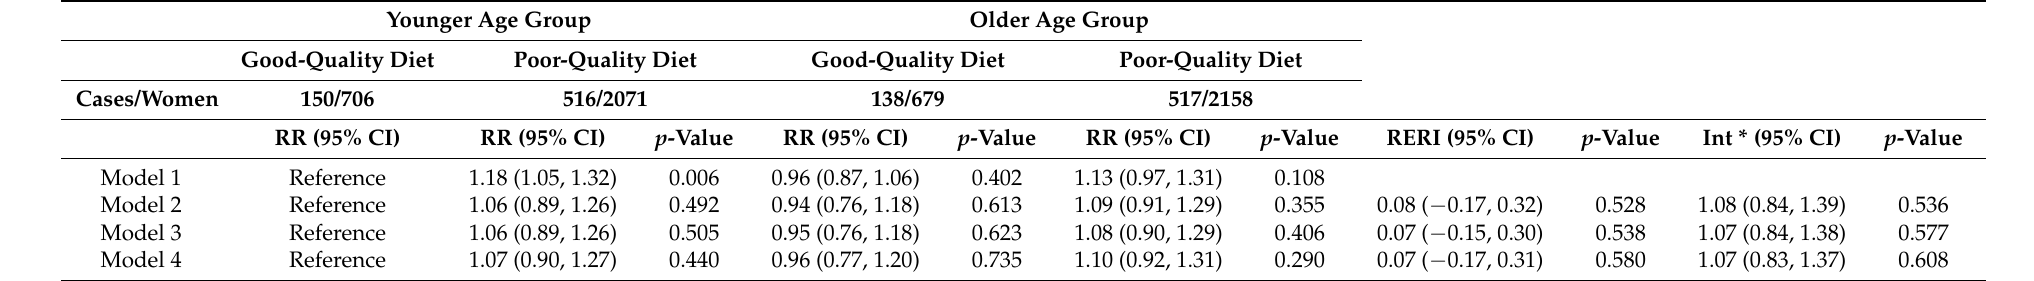
Table 3. Logistic regression models measuring effect modification of age on fertility by diet quality score [Survey 5]. Younger Age